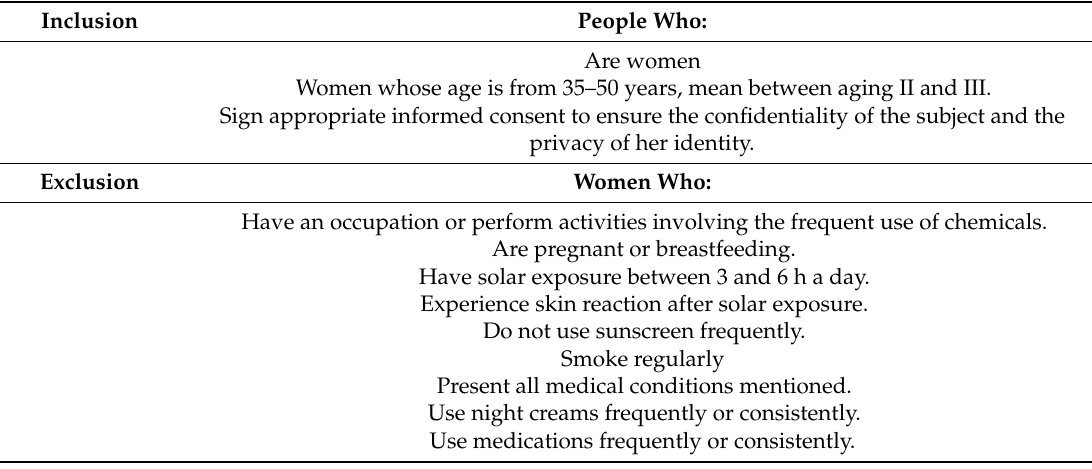
Table 3. Inclusion and exclusion criteria for selecting the